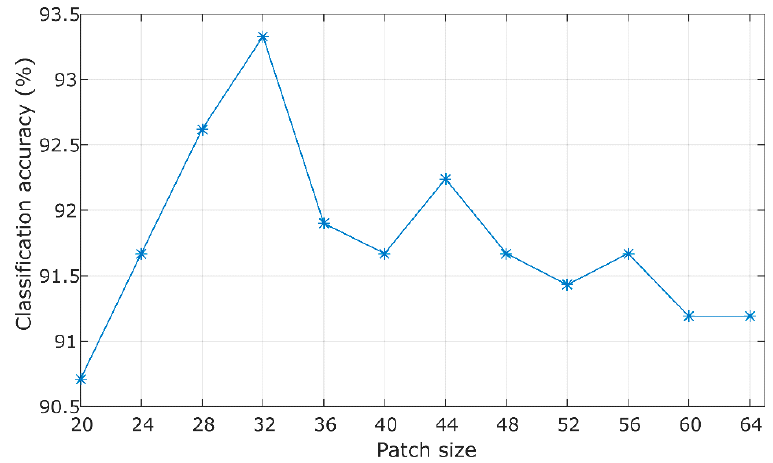
Figure 11. Classification accuracy (%) versus varying patch sizes for the 21-class land-use dataset.